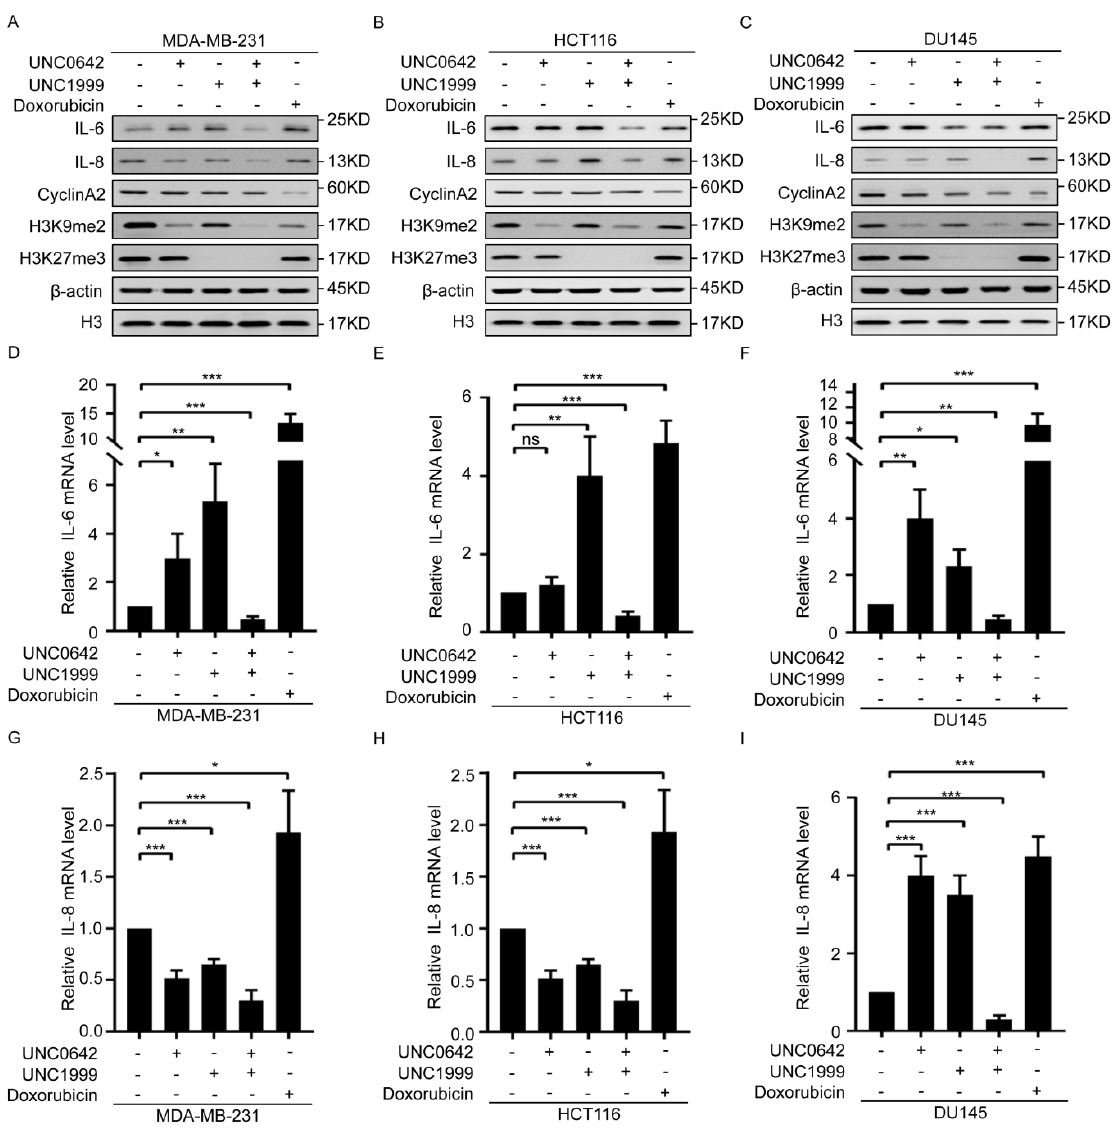
Figure 3. A combination of UNC0642 and UNC1999 inhibits the secretion of SASP. ( A – C ) Western blot analysis of expressions of IL-6, IL-8, CyclinA2, H3K9me2, and H3K27me3 in MDA-MB-231 cells ( A ), HCT116 cells ( B ), and DU145 cells ( C ) treated with indicated treatments. ( D – F ) qRT-PCR analysis of the expression of IL-6 in MDA-MB-231 cells ( D ), HCT116 cells ( E ), and DU145 cells ( F ) treated with indicated treatments. ( G – I ) qRT-PCR analysis of the expression of IL-8 in MDA-MB-231 cells ( G ), HCT116 cells ( H ), and DU145 cells ( I ) treated with indicated treatments. Each experiment was repeated at least three times. Error bars, mean ± SD, ns: no significant, * p < 0.05, ** p < 0.01, *** p < 0.001.